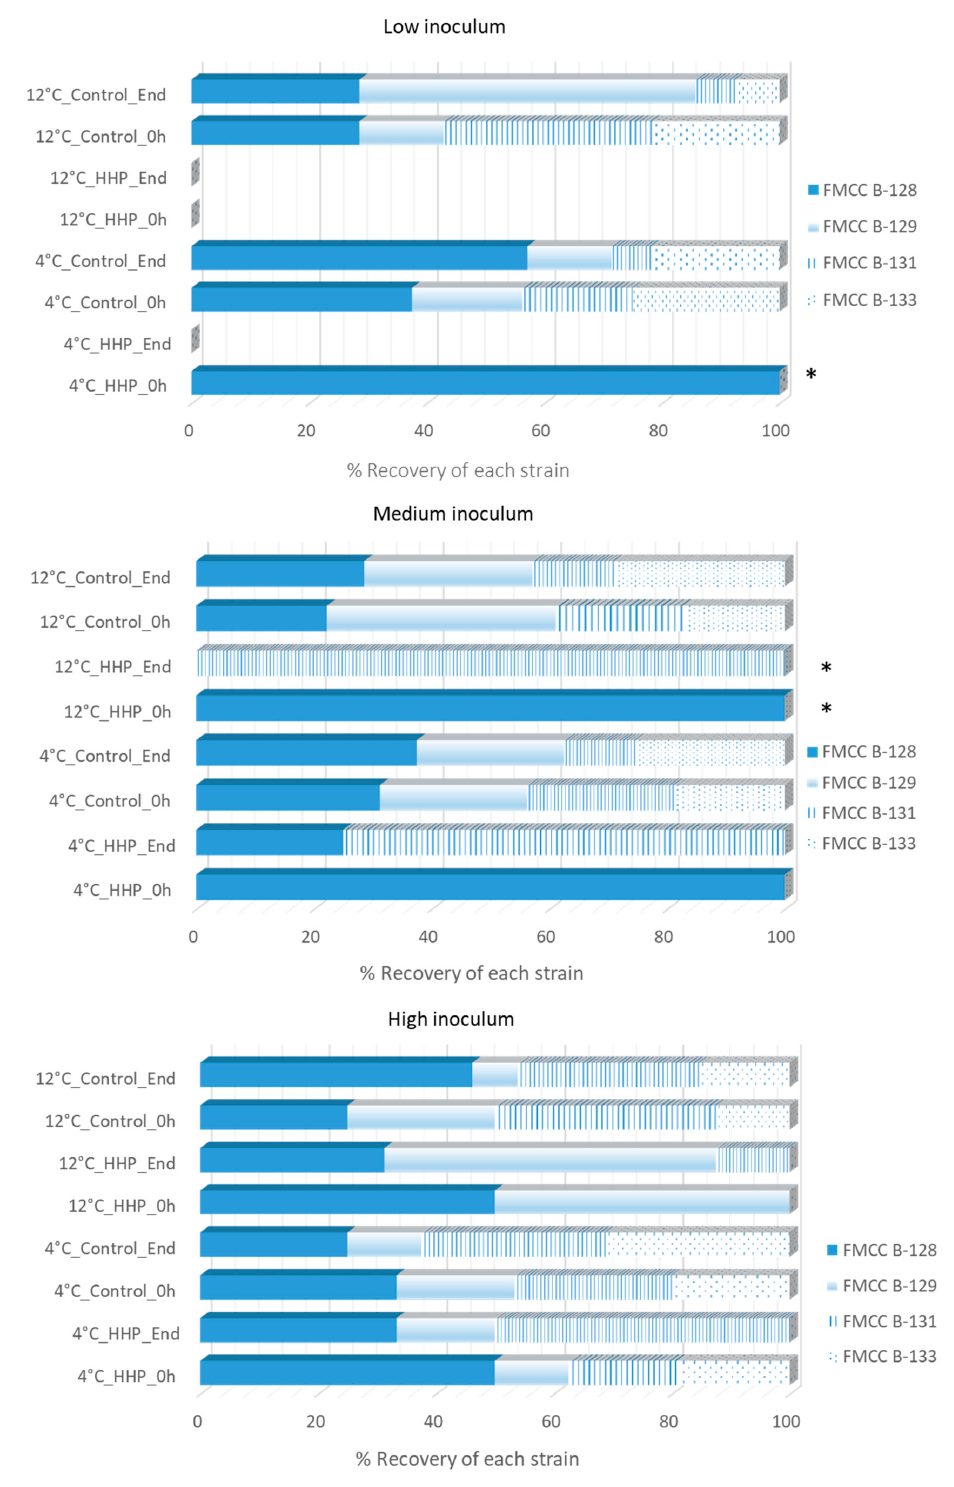
Figure 4. Survival of the di ff erent L. monocytogenes strains (FMCC–B–128, FMCC–B–129, FMCC–B–131, FMCC–B–133) on chicken fillets untreated (control) or HPP–treated (500 MPa / 10 min) with low, medium, and high levels of L. monocytogenes initial inoculum, at the beginning (0 h) and the end of storage under vacuum package at 4 ◦ C and 12 ◦ C. * Pathogen detected after applying the enrichment